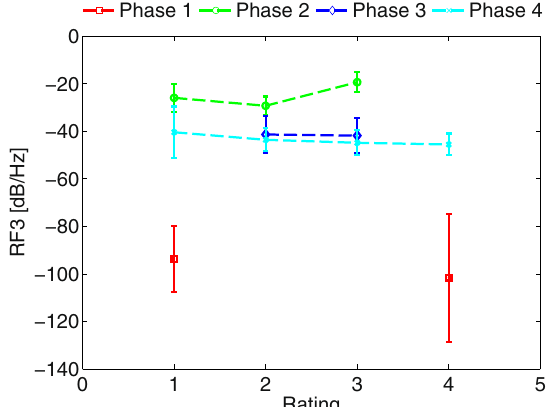
Figure 1. Standard deviation and mean of RF3 against pilots perceived stress rating (1–most perceived stress, 4–least perceived stress) across all flight phases (1–before engine failure, 2–engine failure, 3–glide, 4–approach and landing).